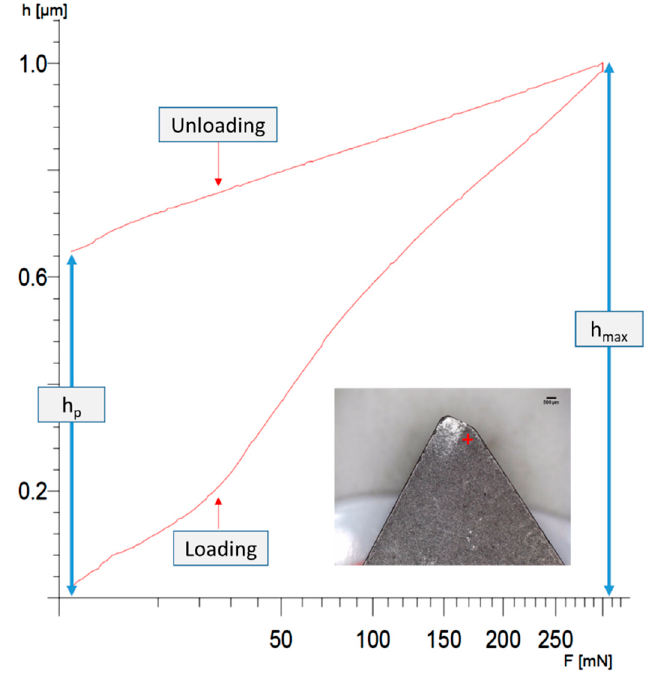
Figure 9. Loading and unloading profile graph obtained during the hardness measurement process .